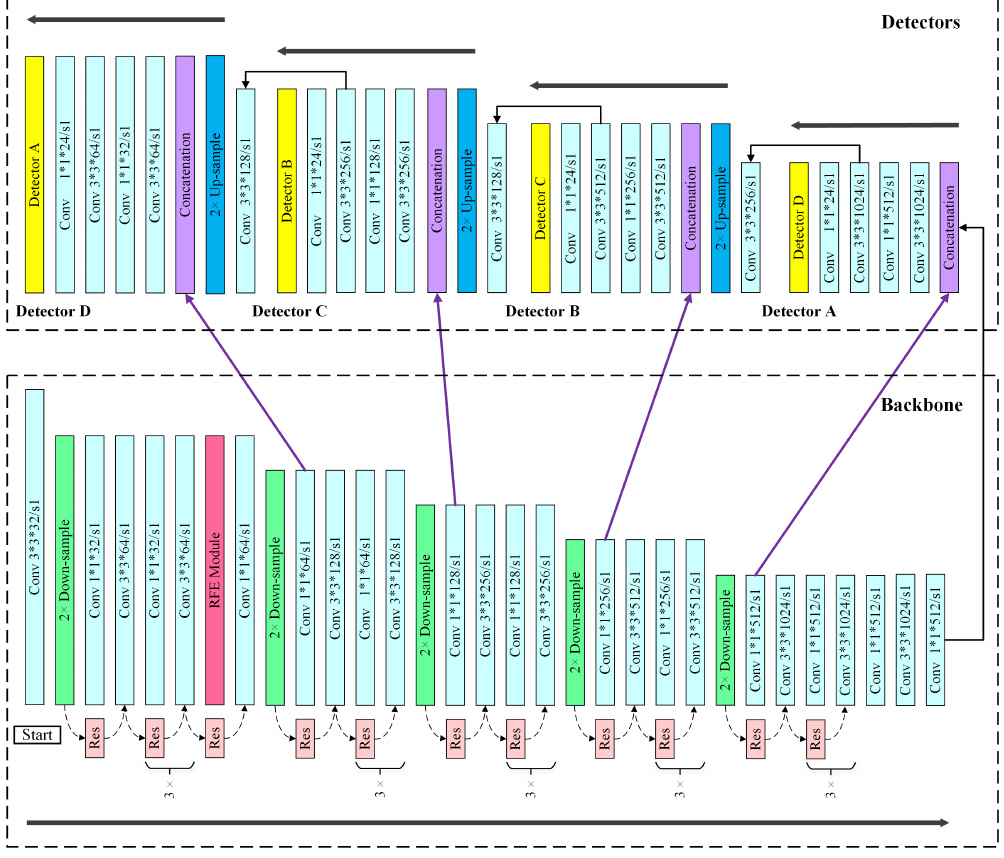
Figure 7. Network structure detail. As a fully convolutional network, NEOON consists of more than fifty convolutions, 21 residual modules and an RFE module in